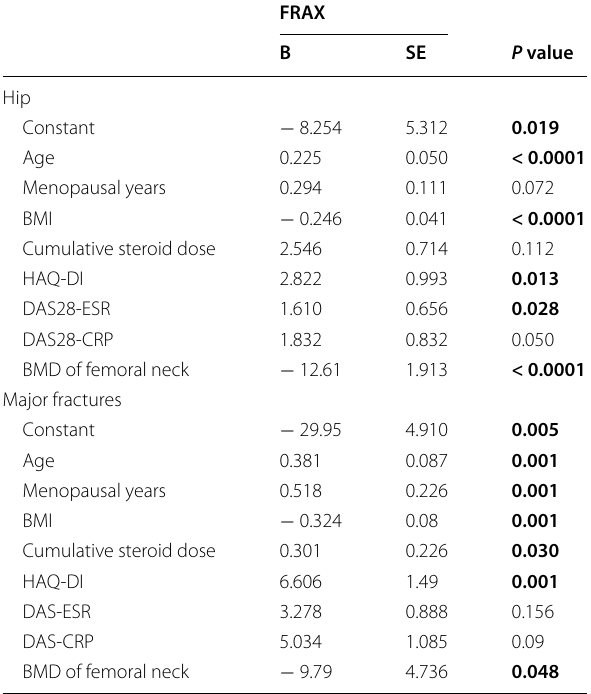
Table 4 Multiple linear regression analysis models of the significant predictors of hip and major fractures FRAX in RA